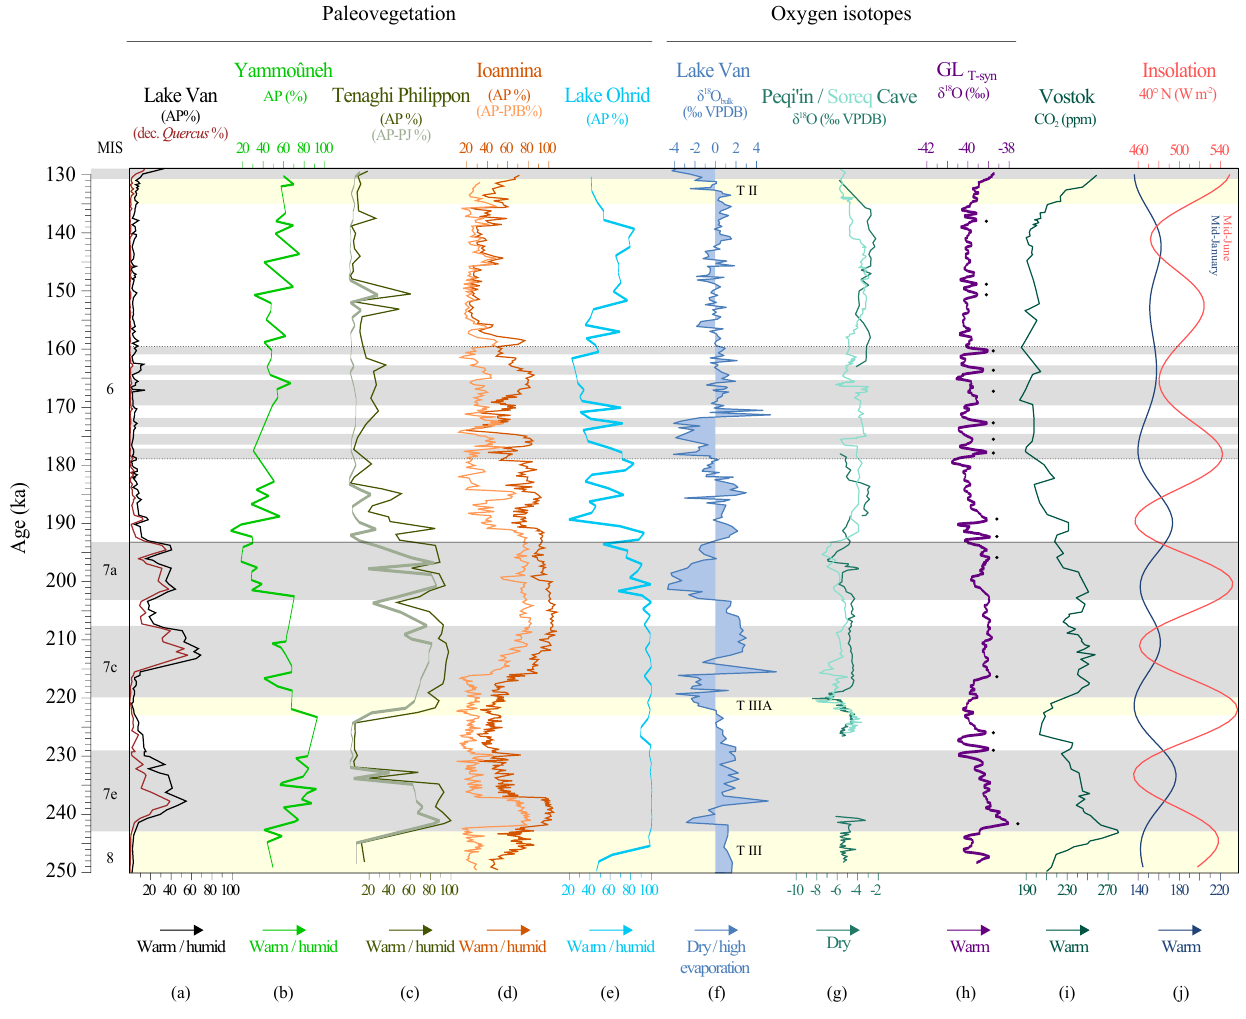
Figure 5. Comparison of Lake Van pollen archive with terrestrial, marine, and ice core paleoclimatic sequences on their own timescales. (a) Total arboreal pollen (AP %) and deciduous Quercus curve from Lake Van (this study). (b) Arboreal pollen percentages from Yammoûneh basin (Lebanon; Gasse et al., 2015). (c) AP including (green) and excluding (light green) Pinus and Juniperus (PJ) percentages of the Tenaghi Philippon record (NE Greece; Tzedakis et al., 2003b). (d) AP sequence from Ioannina basin including (orange) and excluding (light orange) Pinus , Juniperus , and Betula (PJB; NW Greece; Roucoux et al., 2011, 2008). (e) Lake Ohrid pollen record (AP %; Macedonia, Albania; Sadori et al., 2016). (f) Stable oxygen isotope record of Lake Van ( δ 18 O bulk data including the already published isotope record of Kwiecien et al., 2014). (g) Peqi’in Cave and Soreq Cave speleothem records (Israel; M. Bar-Matthews & A. Ayalon, unpubl. data). (h) Synthetic Greenland ice core record (GL T − syn ; Barker et al., 2011). (i) Atmospheric CO 2 concentration from Vostok ice core, Antarctica (Petit et al., 1999). (j) Mid-June and mid-January insolation for 40 ◦ N (Berger, 1978; Berger et al., 2007). Bands highlight periods of distinctive climate signature discussed in the text. Black dots mark significant interstadial periods. Marine isotope stage is also shown (MIS; Lisiecki and Raymo, 2004). Termination III at 250ka, TIIIA at 223ka, and TII at 136ka are indicated after Barker et al. (2011) and Stockhecke et al.